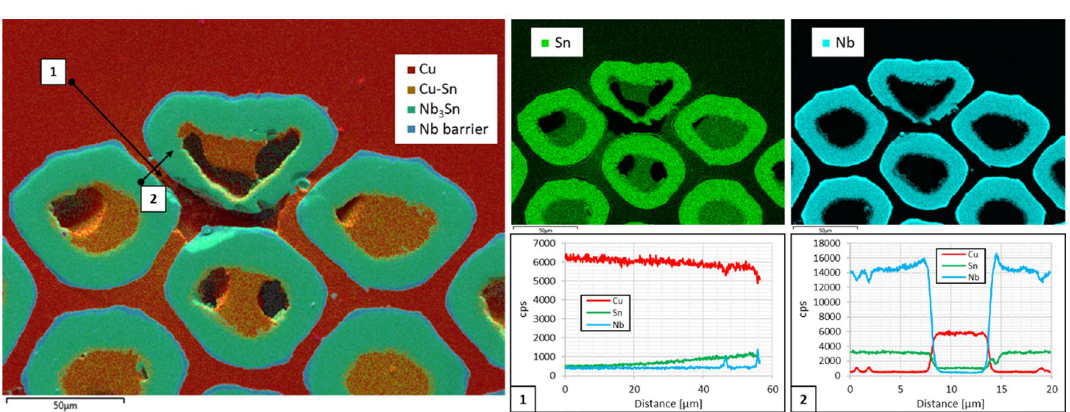
Figure 6. SEM–EDX analysis of a cross section of S20. The analysis was focused on the void located in the Cu matrix. The image on the left shows the EDX map of the cross section and every color indicate a different element of the wire. The EDX maps of Sn and Nb are the top right pictures. The Sn map shows the diffusion of the material outside the sub-elements. The EDX line scan 1 and 2 show the gradient of the Sn diffusion from the void into the Cu